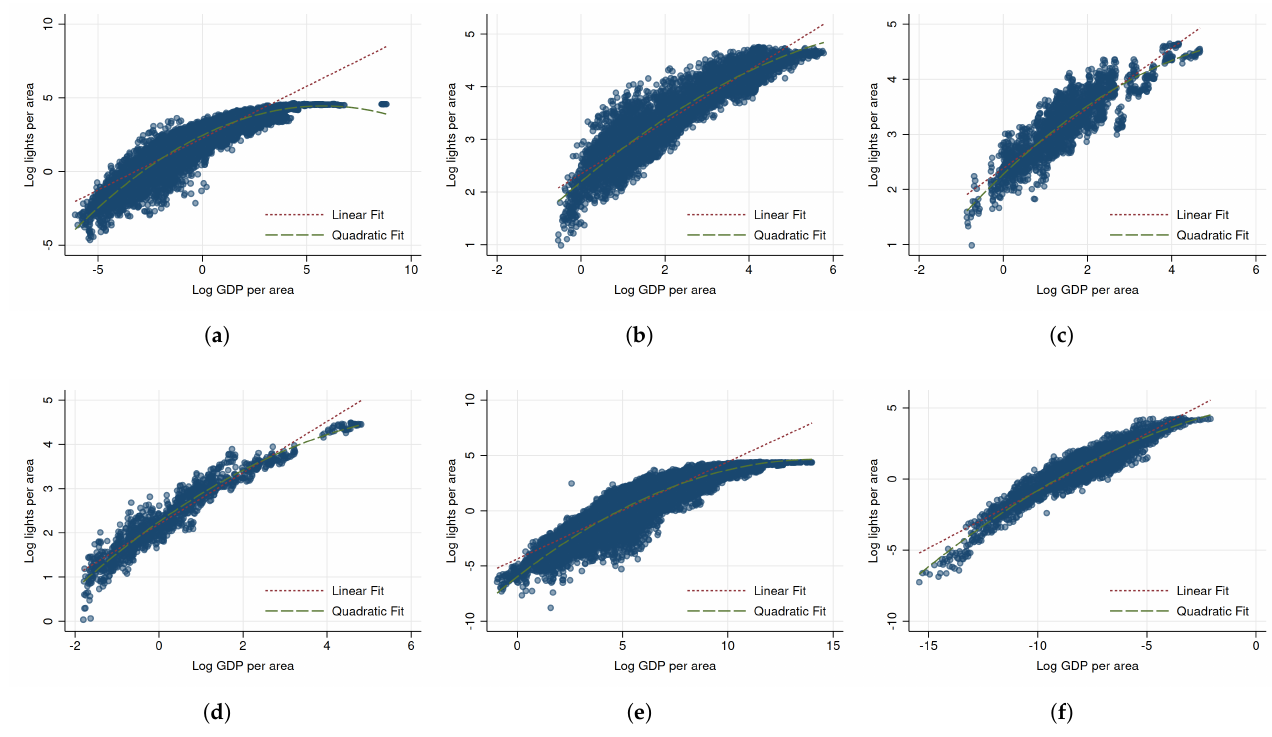
Figure 1. Raw correlation of nighttime lights with real GDP, in logarithms. ( a ) USA, ( b ) Germany, ( c ) Italy, ( d ) Spain, ( e ) Brazil, ( f )